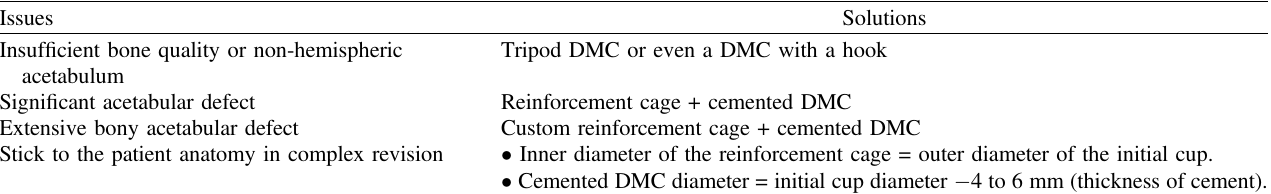
Table 1. Issues and their solutions regarding implant